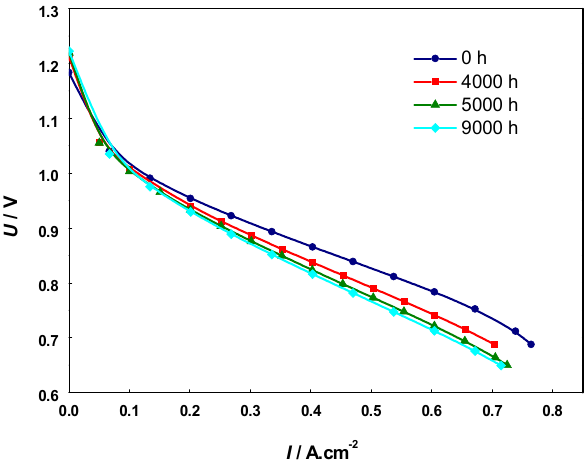
Figure 10. Current-voltage ( i -V) curves of calendar aged cell operated for 9000 h. Table 2. Voltage decrease at constant current density extracted from i -V curves measured during 9000 h field testing [70]. The impedance measurements for the monitoring and analysis of the cell behavior during redox cycling were performed in both the oxidized and reduced states. As pre- sented in Figure 11, during oxidation mainly the lower frequency part of the impedance (100 Hz–1 Hz) increases. The potential varies between 915 mV in the oxidized state and 1015 mV in the reduced state, since the cell does not reach the normal operating conditions between two cycles. Figure 11. Impedance diagrams of button cell measured during the 20th redox cycle: Oxidized state ( ○ ); Reduced state ( ∆ ). The impedance measurements can be also used for evaluation of the depth of degra-